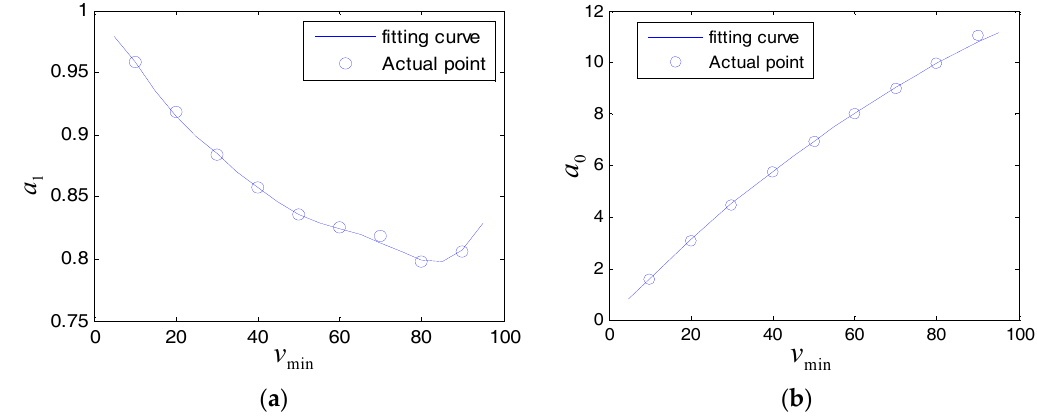
Figure 10. The relationship between similarity factors and minimum. ( a ) The relationship between (cid:1874) (cid:2923)(cid:2919)(cid:2924) and (cid:1853) (cid:2869) ( b ) The relationship between (cid:1874) (cid:2923)(cid:2919)(cid:2924) and (cid:1853) (cid:2868)